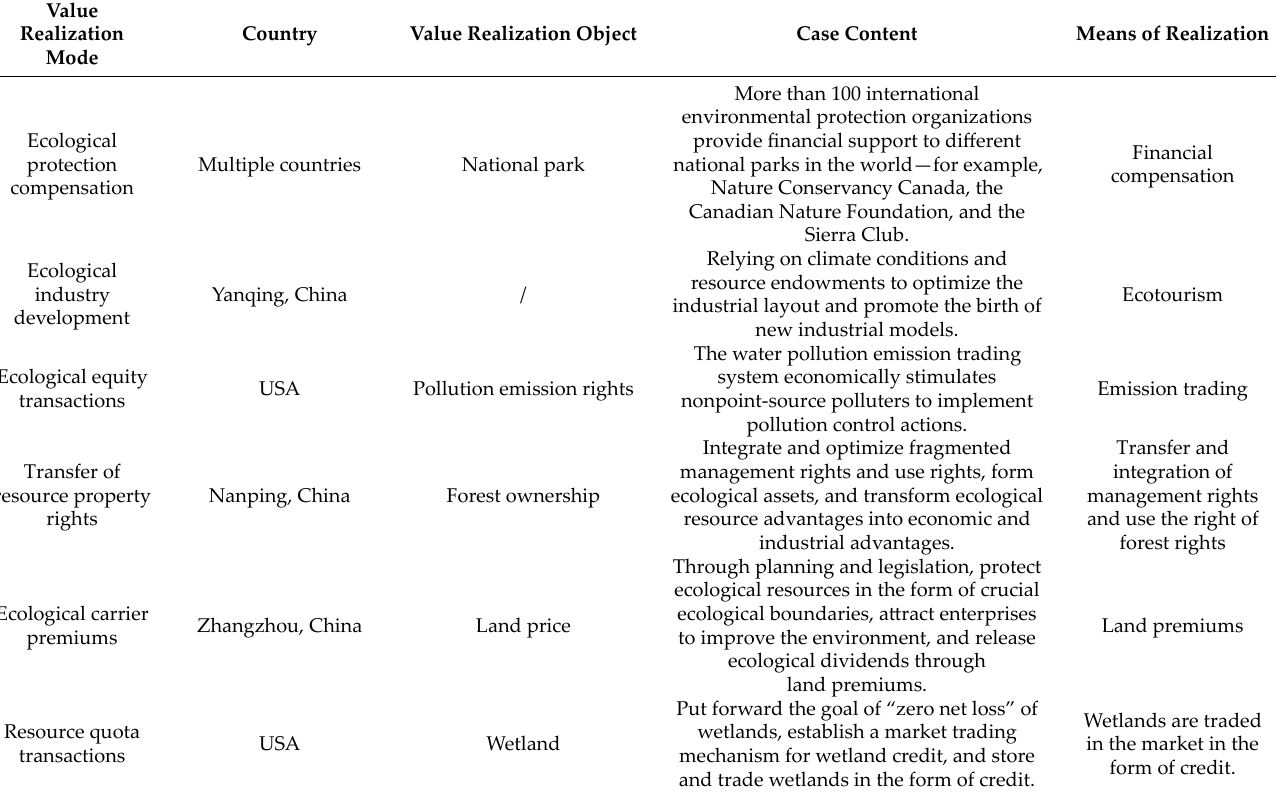
Table 1. Typical cases of realizing the value of ecological